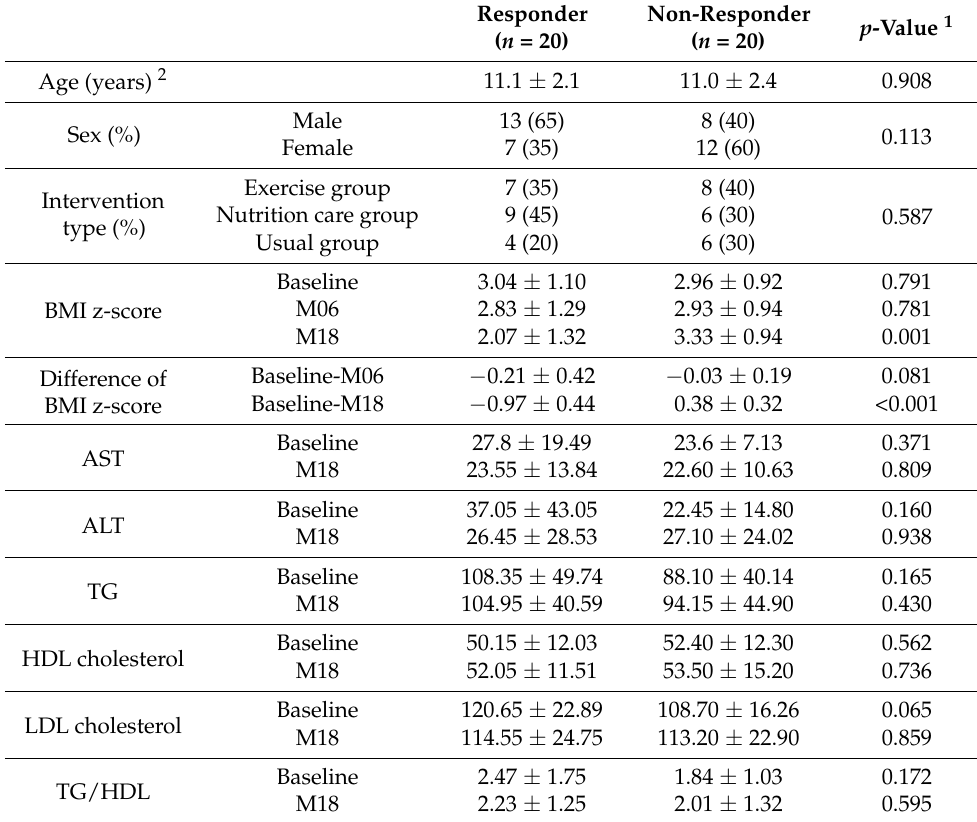
Table 1. Demographic characteristics of the study